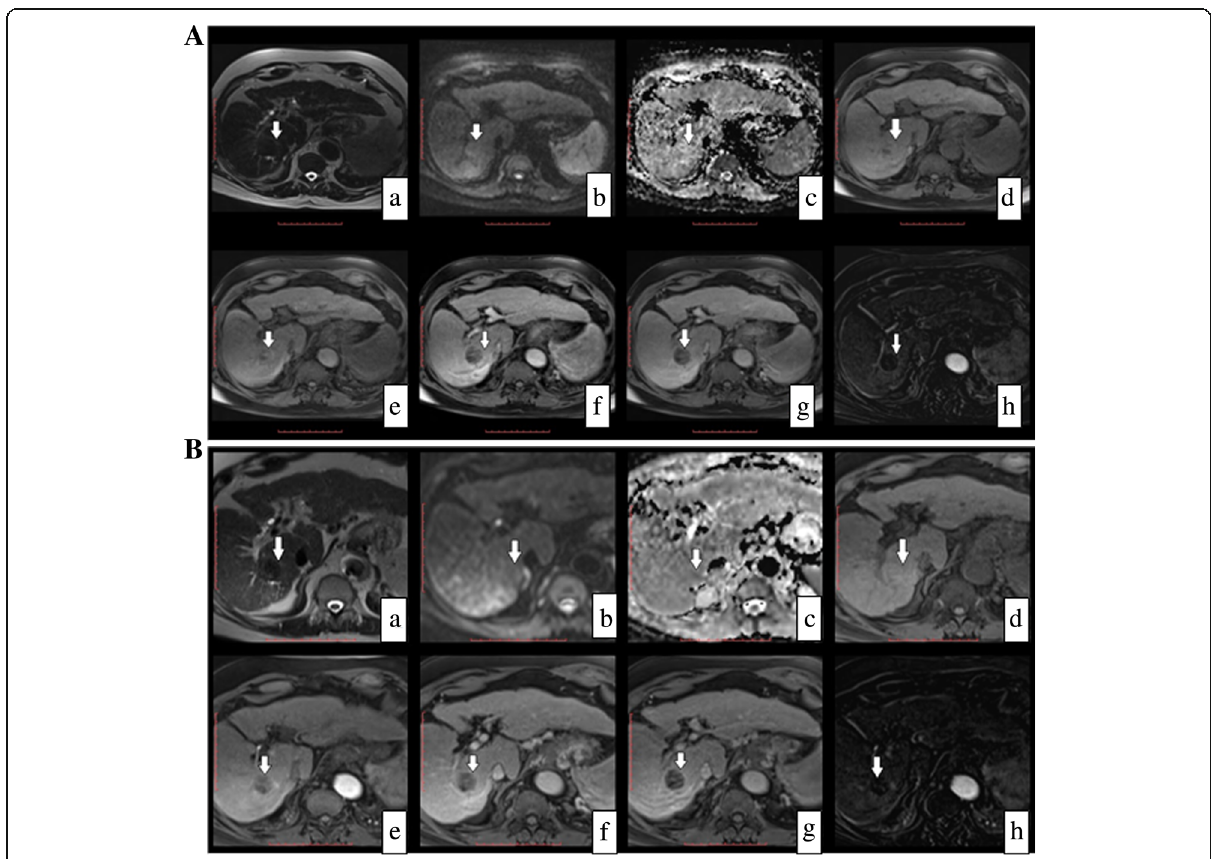
Fig. 7 A 70-year-old male patient with hepatitis-related liver cirrhosis and single segment V/VI HCC lesion. He had a TACE session and came for follow up 1 month later. (A) Follow up dynamic MRI 1 month post TACE. a T2WI, b DWI image, c ADC image, d T1WI, e late arterial phase, f portal phase, g delayed phase, and h late arterial subtracted image. The treatment zone elicits low to isointense signal in T2WIs, and iso to high signal in T1WIs. It measures about 3.4 × 2.4 cm in diameter with high central signal in the arterial phase worrisome for residue. ADC value measured (1.3 × 10 − 3 mm 2 /s). Subtraction removed the central high signal thus excluding residual disease (false positive dynamic study interpretation). (B) Follow up dynamic MRI 3 months post TACE. a T2WI, b DWI image, c ADC image, d T1WI, e late arterial phase, f portal phase, g delayed phase, and h late arterial subtracted image. Regression in the size of the treatment zone with still no contrast uptake confirming